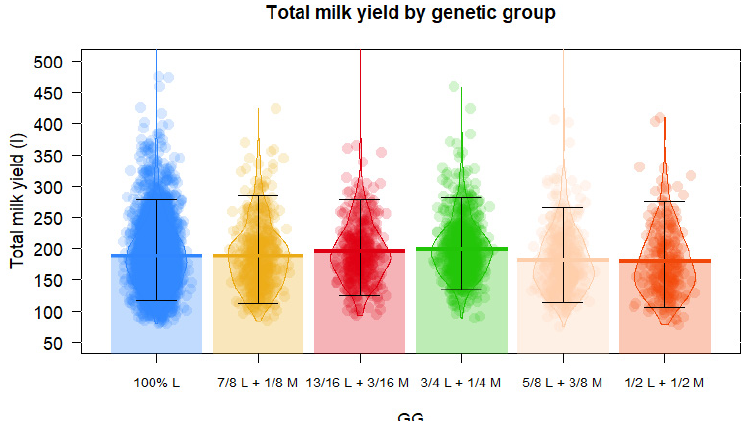
Figure 1. Pirate plot of the effect of genetic group on total milk yield of dairy sheep from a commercial flock in Spain. (GG, genetic group; L, Lacaune; M, Manchega crossbreeding with Lacaune; points represent the raw data; bar/line is the descriptive statistic (mean); bean is the smoothed density curve showing the full data distribution; and brackets represent the confidence intervals). Table 4 and Figure 2 show the lactation curves, where the 100% Lacaune genotype obtained the highest PY (1.69), and the genotypes with shorter TPY were 7/8 Lacaune + 1/8 Manchega, followed